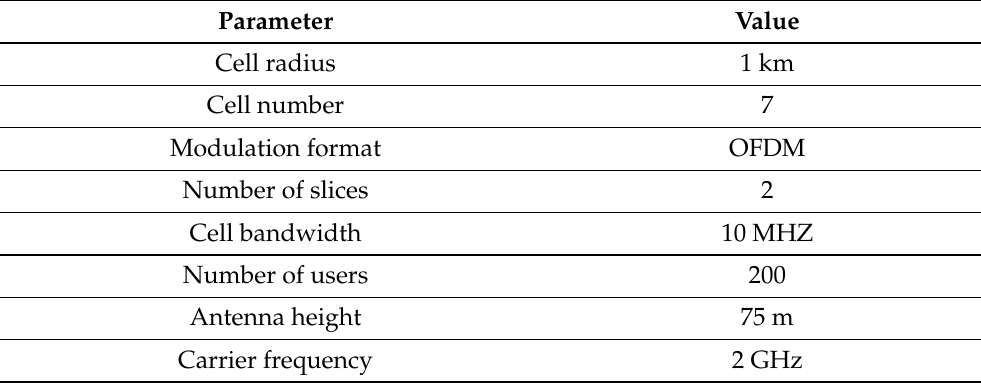
Table 3. Simulation